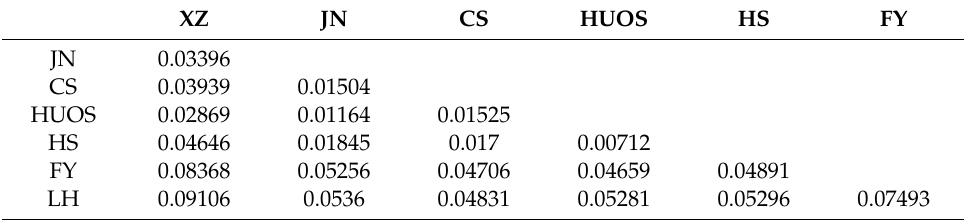
Table 4. Pairwise fixation index (Fst) values among seven populations of Chinese elm.